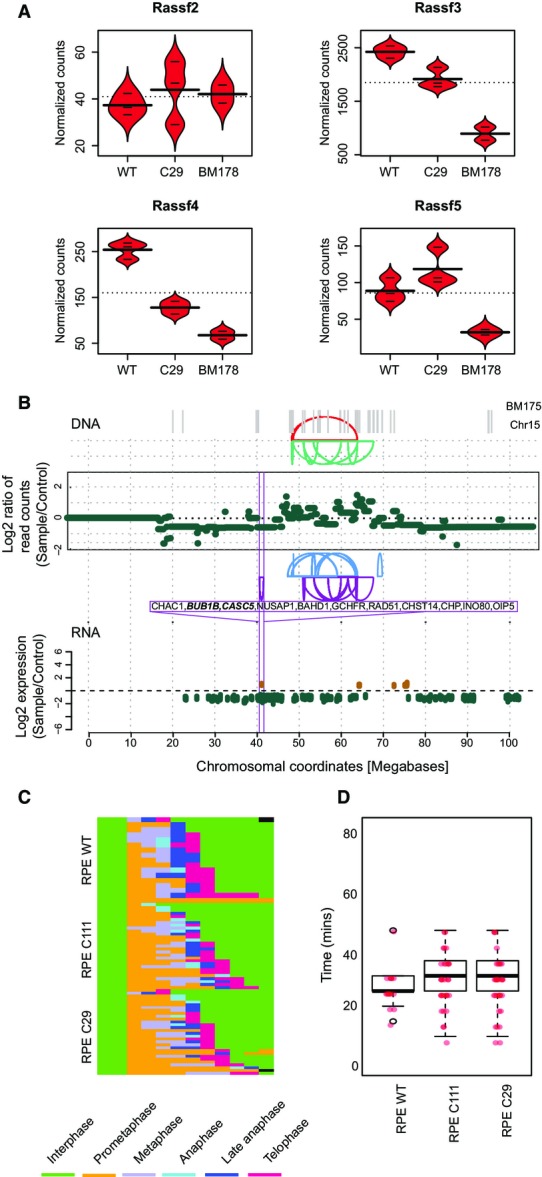
Transcriptional consequences of chromothripsis
Transcriptional regulation of RASSF2/3/4/5. Bean plots from normalized counts of each mRNA are shown for RPE-WT, RPE-C29, and BM178. Horizontal lines represent values from individual samples, whereas thick horizontal lines indicate average values. Experiments were done in triplicates. Except for RASSF2, which exhibited very low read counts in our cell lines, all other members showed significant downregulation in BM178 (Padj < 0.1).

Significantly differentially expressed genes on chromosome 15 of BM175 (compared to the parental cell line C29) at an FDR of 10%. Log2-fold changes of each gene are shown. In the above panel, copy number segments and SRs affecting chromosome 15 are depicted. Genes significantly affected by this SR are highlighted in green (downregulation) and brown (upregulation).

Individual tracks of mitotic cells that were imaged and analyzed automatically by CellCognition (www.cellcognition.org). Each mitotic class is color-coded as indicated in the legend (nWT = 15, nC111 = 31, nC29 = 33).

Distribution of timing of mitotic progression (prometaphase, metaphase and anaphase in minutes) in RPE-1 WT and RPE-1 TP53−/− cell lines derived from Fig EV5C. We did not detect any significant changes between WT and TP53−/− cell lines. Box-and-whiskers plots: boxes show the upper and lower quartiles (25–75%) with a line at the median, whiskers extend from the 10 to the 90 percentile and transparent dots correspond to the outliers. Red dots represent individual samples.